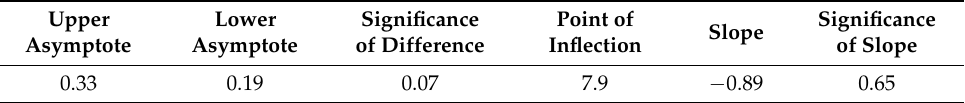
Table 2. Estimated parameters for the logistic regression curves for all training days. The upper asymptote indicates the proportion of naïve animals that received a stimulus during these events. The lower asymptote is the proportion of animals that continued to receive a stimulus. The difference between these is tested for significance. The point of inflection is the mean number of attempts it takes for half of the learning to occur. The slope indicates the speed of transition from the upper to lower asymptote.